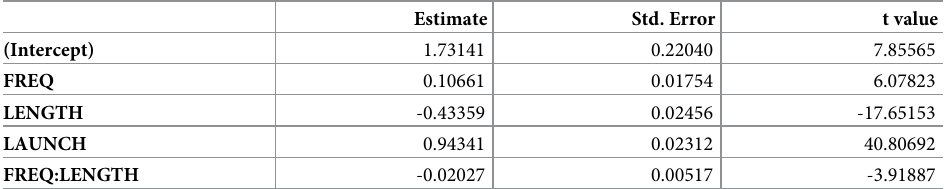
Table 8. Fixed effects of optimal LMM for overall landing